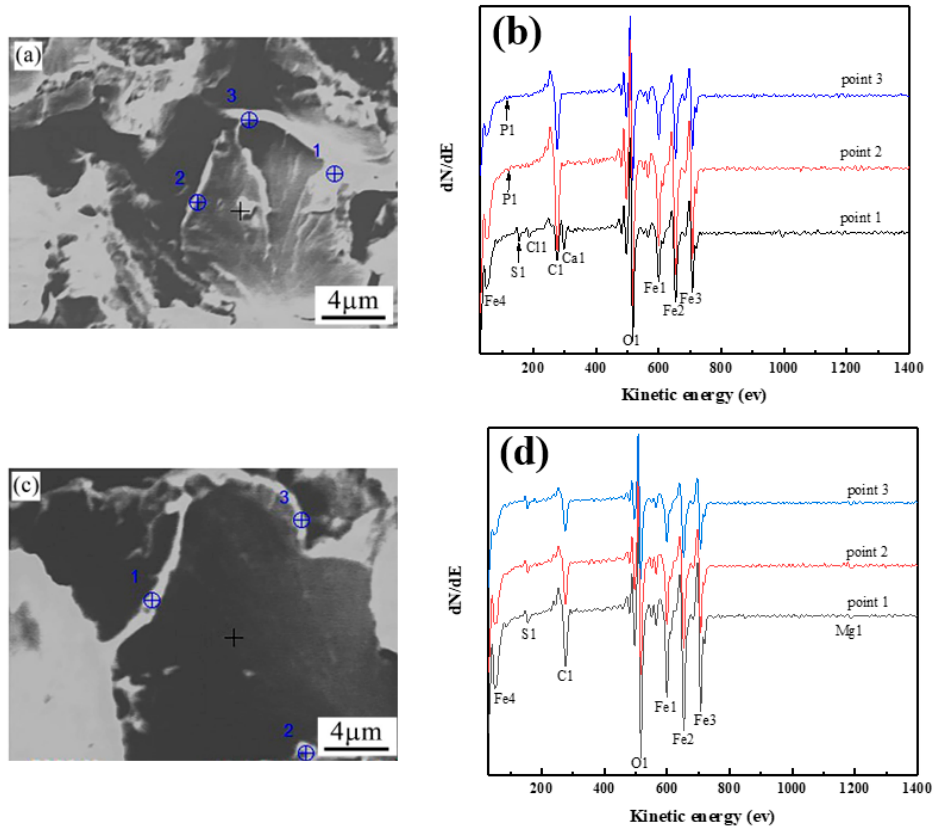
Figure 9. Typical AES spectra of S1 ( a , b ) and S2 ( c , d ) after aging 500 h at 580 °C.